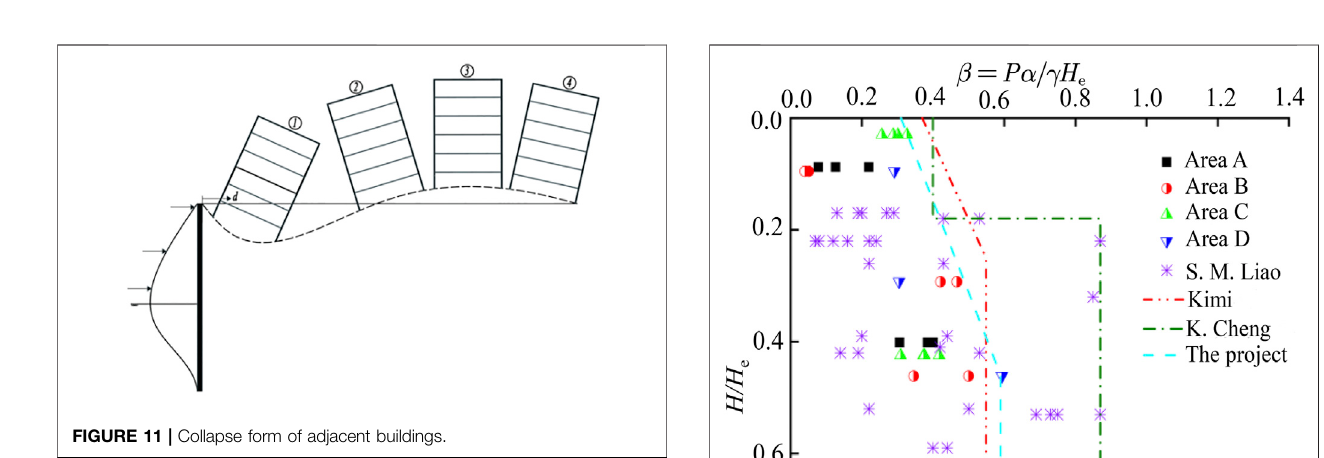
FIGURE 10 | Building heave curve.